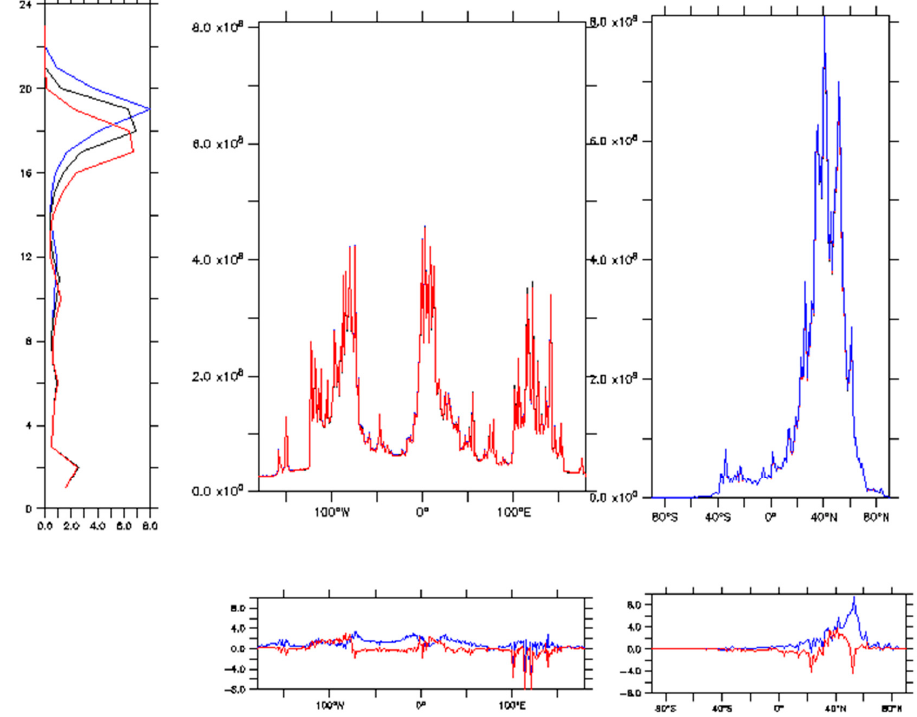
Figure 2. Global distribution of aviation NO x emission mass flux; vertical distribution representing flight levels in 2000 ft steps [10 8 g] ( left ), meridional distribution [g] ( middle ), zonal distribution [g] ( right ): reference case (REACT4C, black), Flying Higher (blue), Flying Lower (red) and differences [10 7 g] (bottom row): ‘ Higher— reference case’ (blue) and ‘ Lower— reference case’ (red).